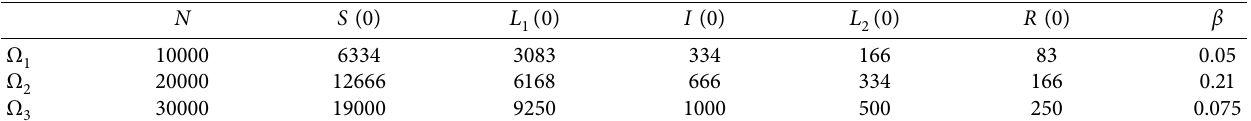
( 0 ) , I ( 0 ) ,L ( 0 ) , and R ( 0 ) associated with the three regions Ω 1 2